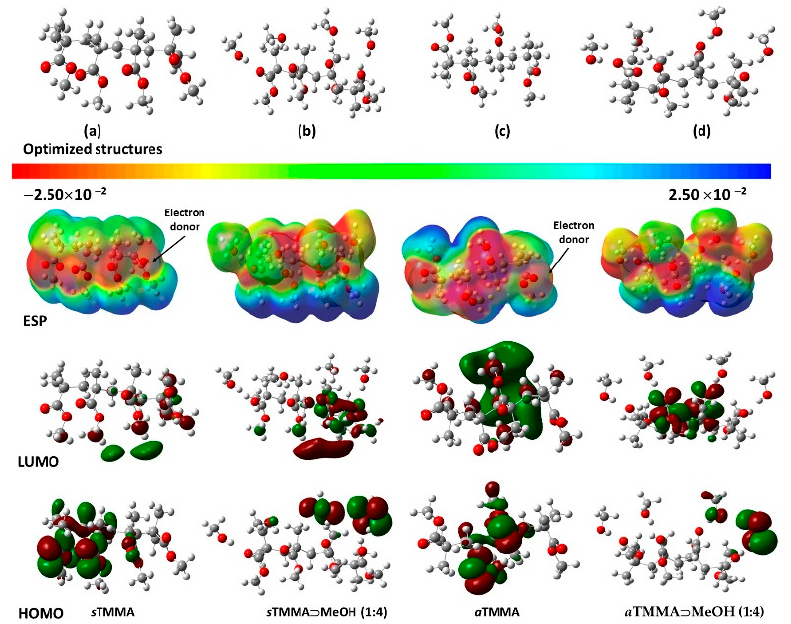
Figure 10. Optimized gas phase molecular structures, ESP, LUMOs and HOMOs structures of sTMMA; a TMMA and their 1:4 complexes with methanol: ( a ) s TMMA; ( b ) s TMMA ⊃ MeOH; ( c )